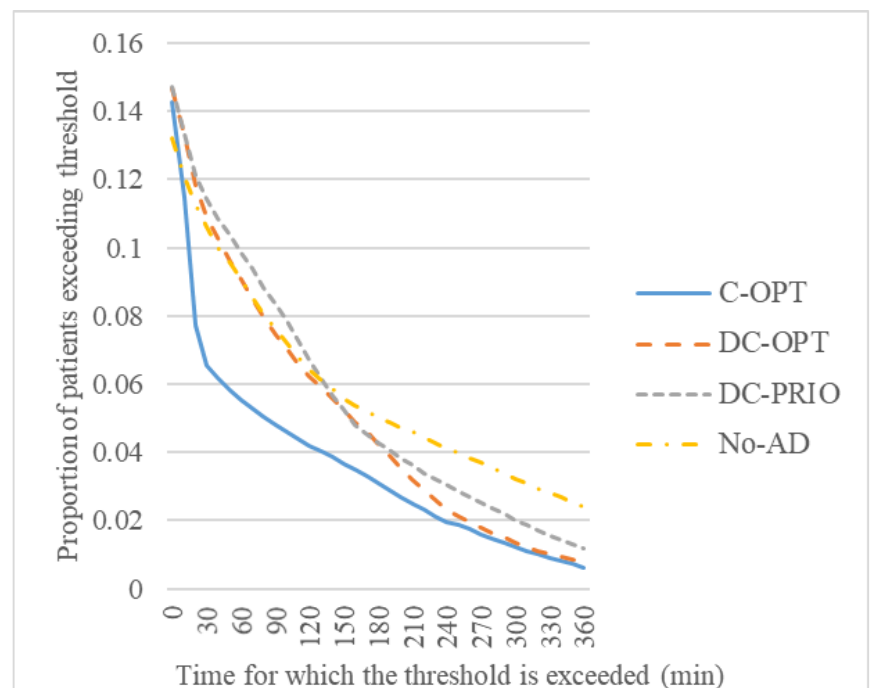
Figure 5. Proportion of patients exceeding the threshold.